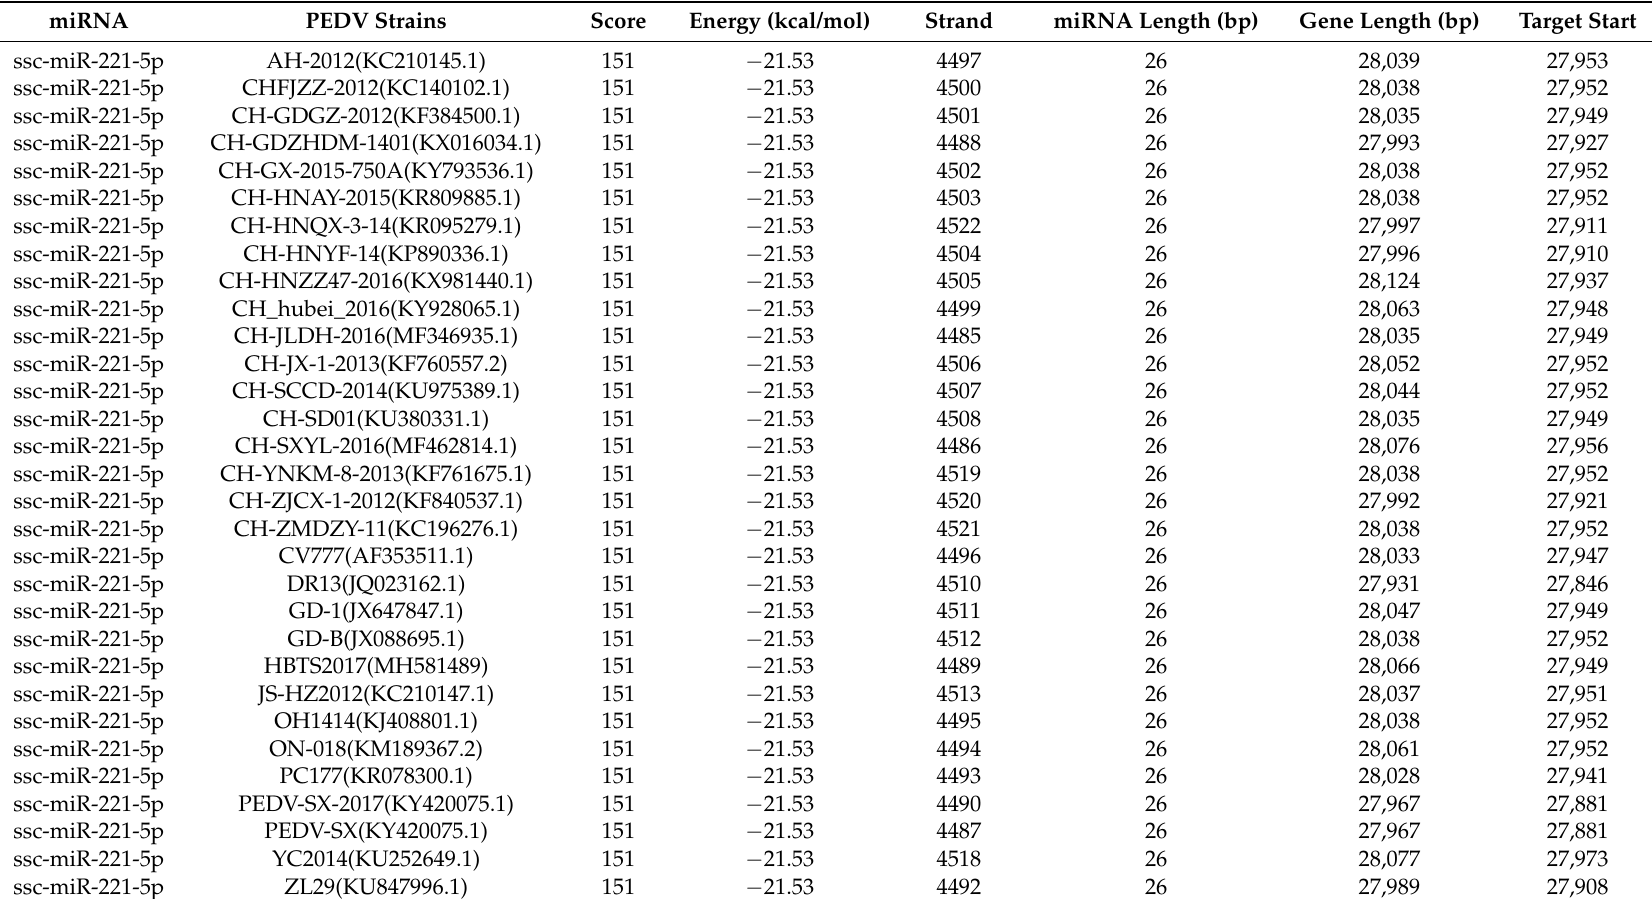
Table 1. Prediction of miRNA target sites (TSs) on genomic RNA from group 1 and 2 PEDV